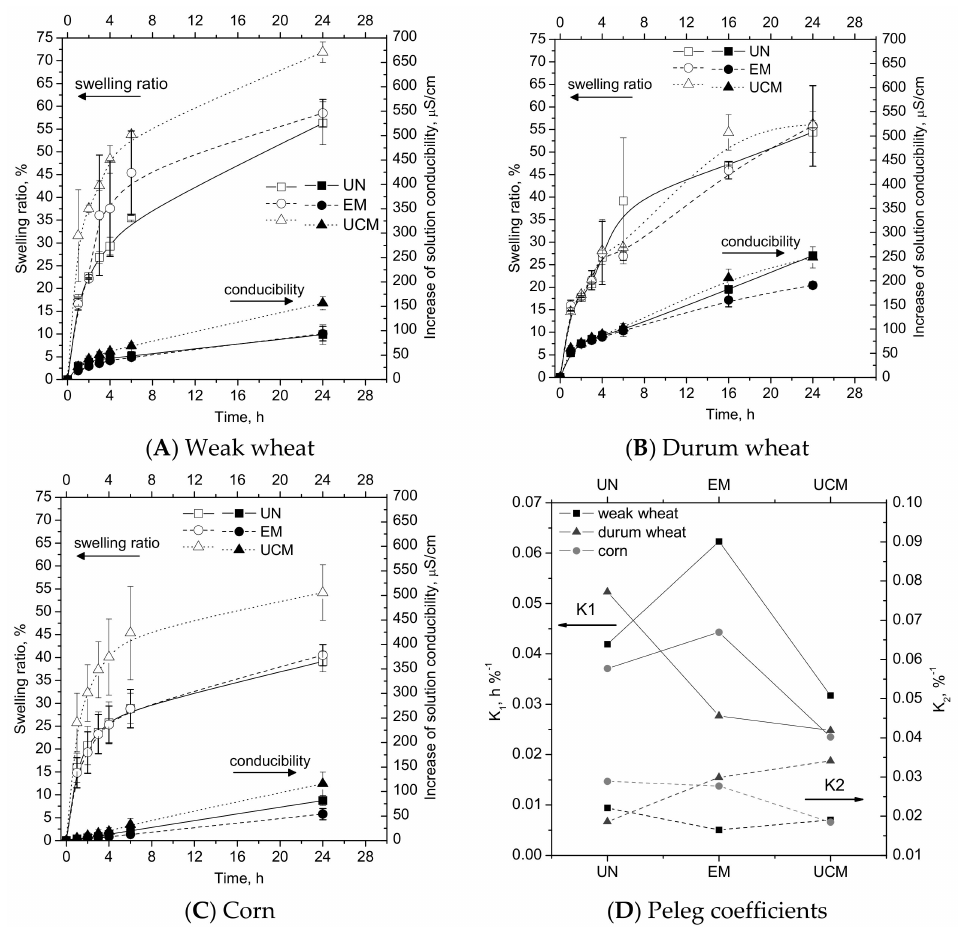
Figure 3. Percentage of swelling ratio (left side, open symbols) and solution conductibility increase (right side, closed symbols) for UN (squares), EM (circles), and UCM (triangles) grains of weak wheat ( A ), durum wheat ( B ), and corn ( C ). ( D ) Peleg coe ffi cients ( K 1 left side, K 2 right side) for UN, EM and UCM weak wheat (squares), durum wheat (triangles), and corn